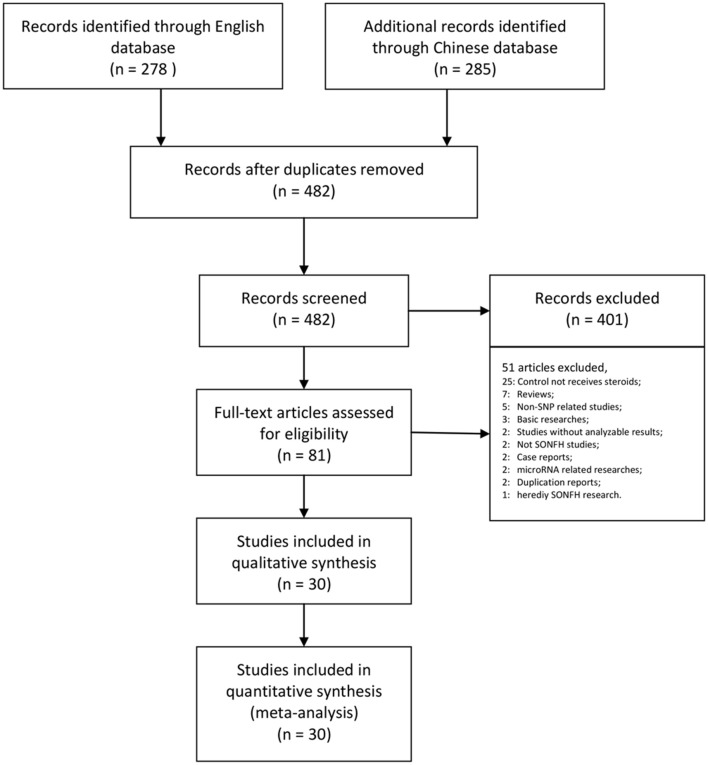
PRISMA flow chart illustrating the selection process of the studies included in our analysis. SNP, single-nucleotide polymorphism; SONFH, steroid-induced osteonecrosis of the femoral head.